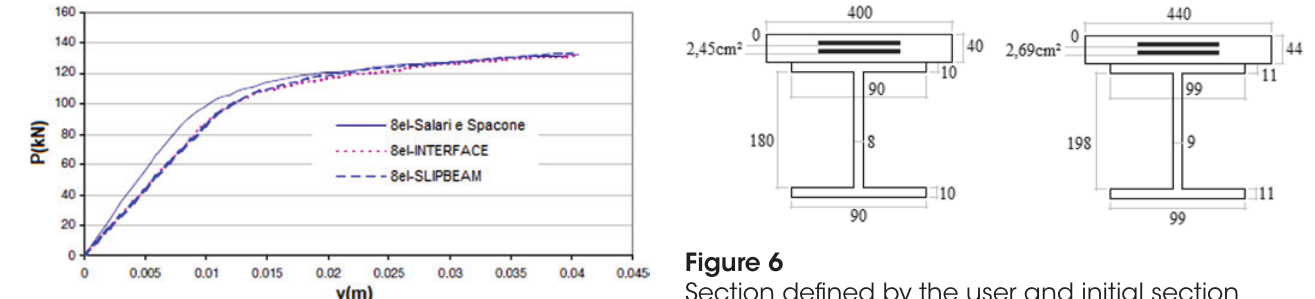
Section defined by the user and initial section defined by the algorithm (dimensions in mm)